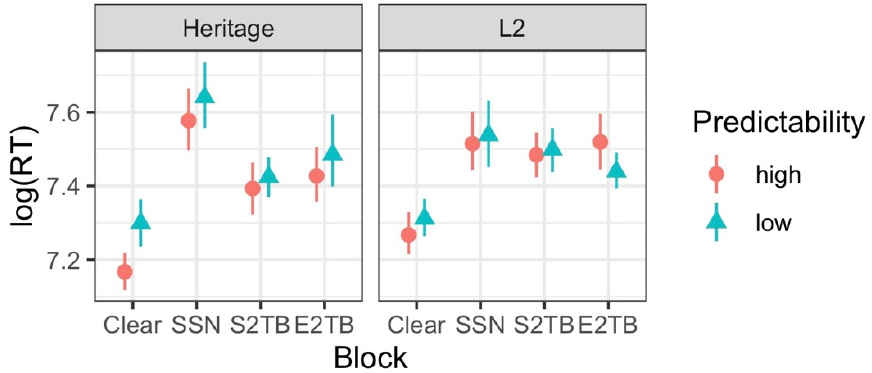
Figure 2. Raw response time data from the speech-in-noise transcription task. (SSN = speech-shaped noise, S2TB = Spanish two-talker babble, E2TB = English two-talker babble). Table 3. Fitted model examining reaction times for accurate keyword responses in the speech-in-noise recognition